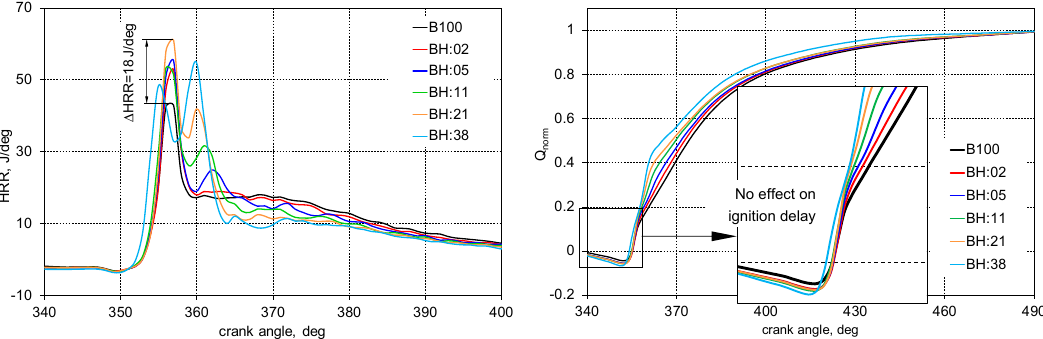
Figure 3. Heat release rate and normalized heat release for different energetic shares of hydrogen.